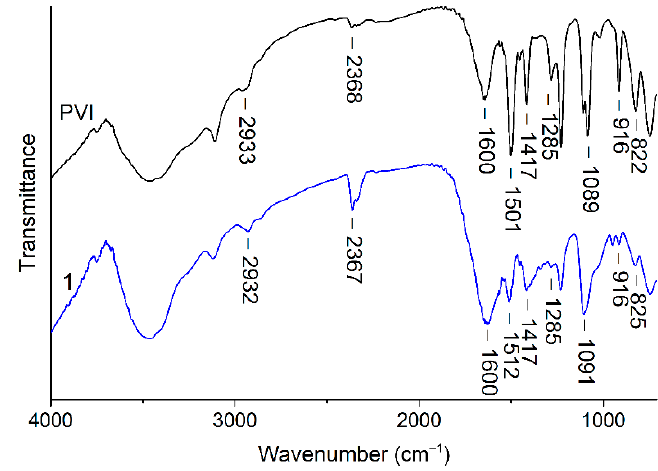
Figure 1. FTIR-spectra of PVI and NC(Cu-PVI)